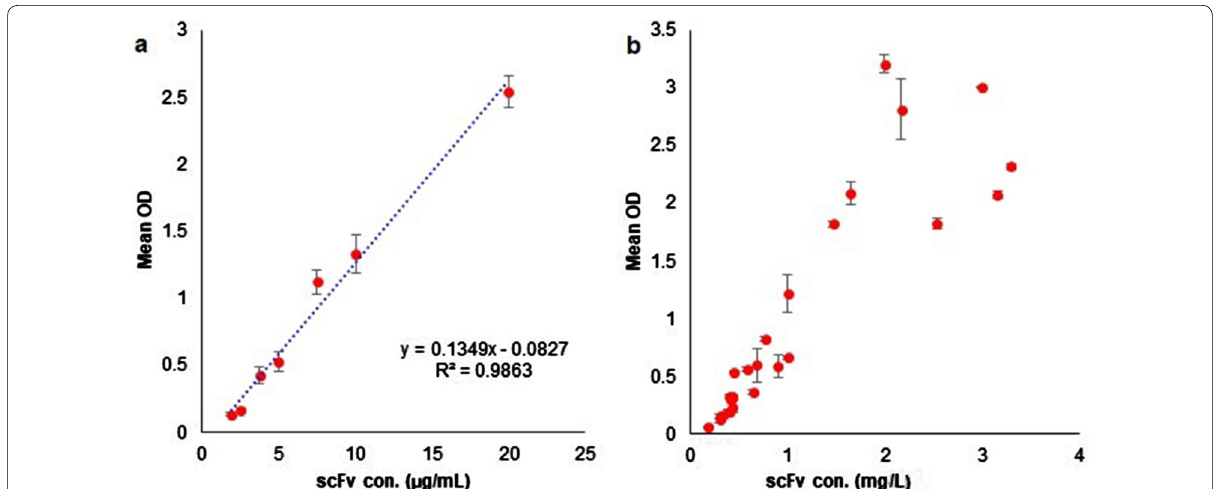
Fig. 2 ELISA analysis. a Shows a calibration curve constructed by twofold dilution series of the purified anti-G17-Gly. The absorbance values and the standard scFv concentrations showed a satisfactory linear correlation considering R 2 > 0.9. b Represents the overall concentration of the anti-G17-Gly scFv extracts under different experimental conditions. The mean absorbance values of the test samples were interpolated to the linear regression equation obtained from the calibration curve. The Mean OD stands for the average absorbance values of duplicate samples read at 450 nm and 630 nm to subtract background